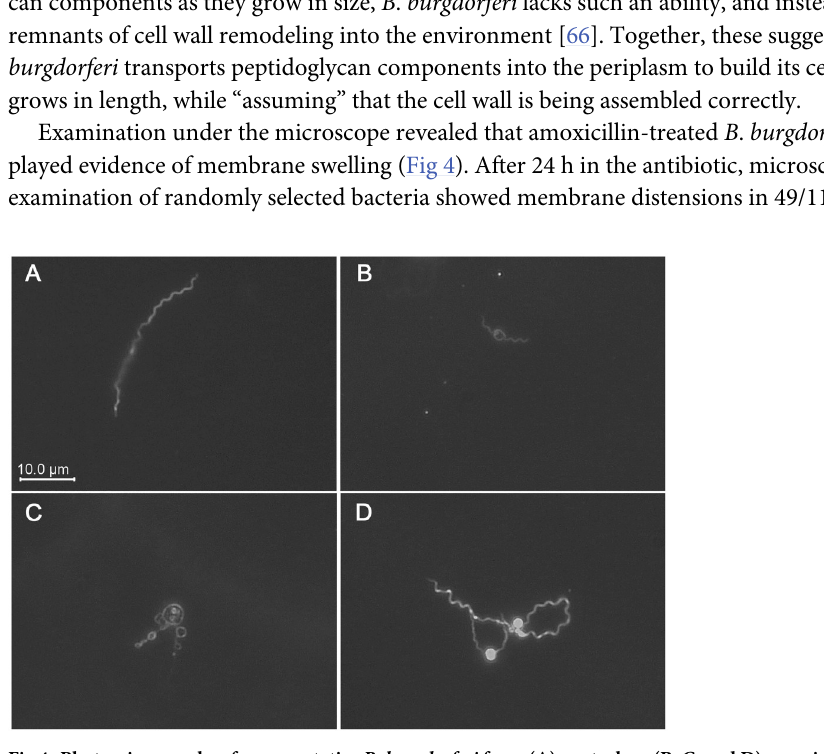
Fig 4. Photomicrographs of representative B . burgdorferi from (A) control, or (B, C, and D) amoxicillin-treated cultures after 24h incubation. All fields are shown at the same relative magnification. Imaged with a 40x objective lens and darkfield